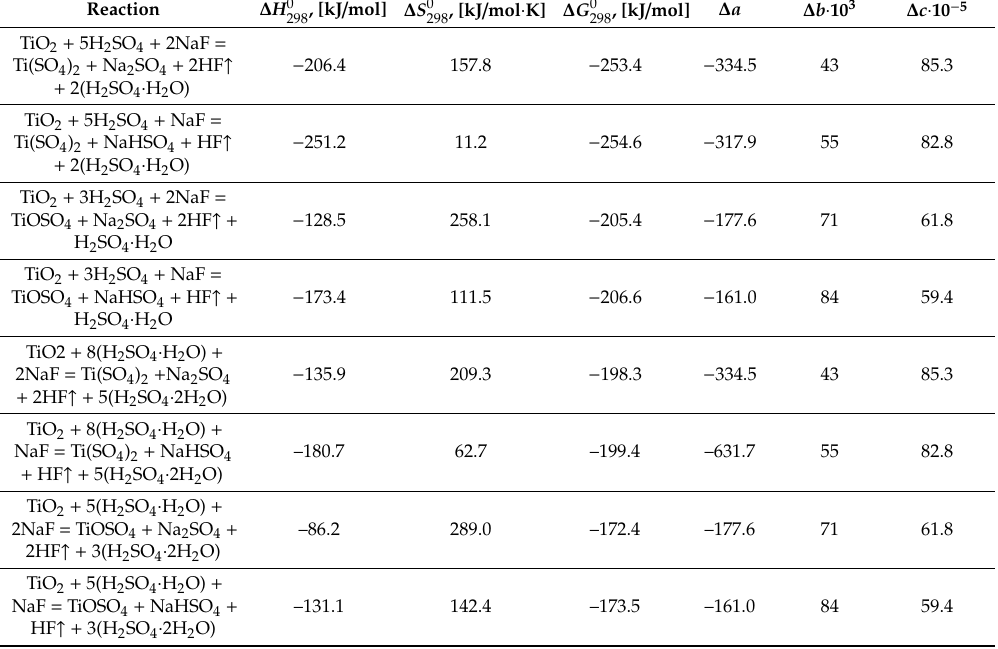
Table 2. Thermodynamic data for chemical transformations in the TiO 2 –NaF–SO 3 –H 2 O system.